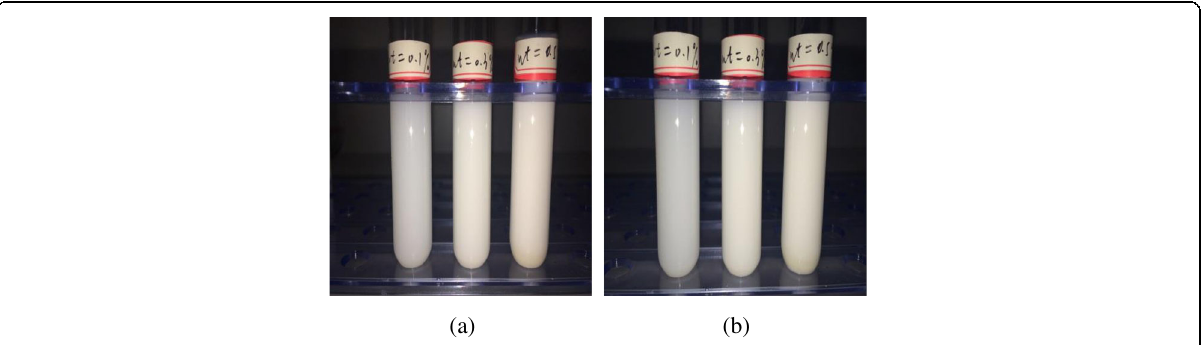
Fig. 3 Stability observation of TiO 2 -water nanofluid. TiO 2 -water nanofluid at different times. a Before laying. b After 72